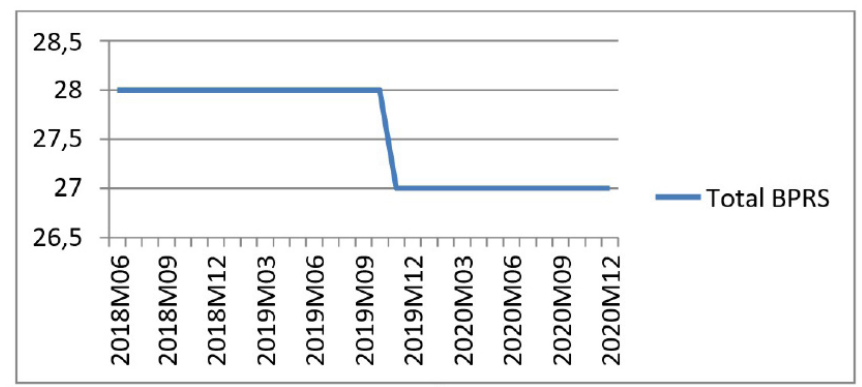
Figure 4 : The Forecasting of Financial Inclusion in East Java through BPRS using Access Indicator Source: Data Processed (2018)